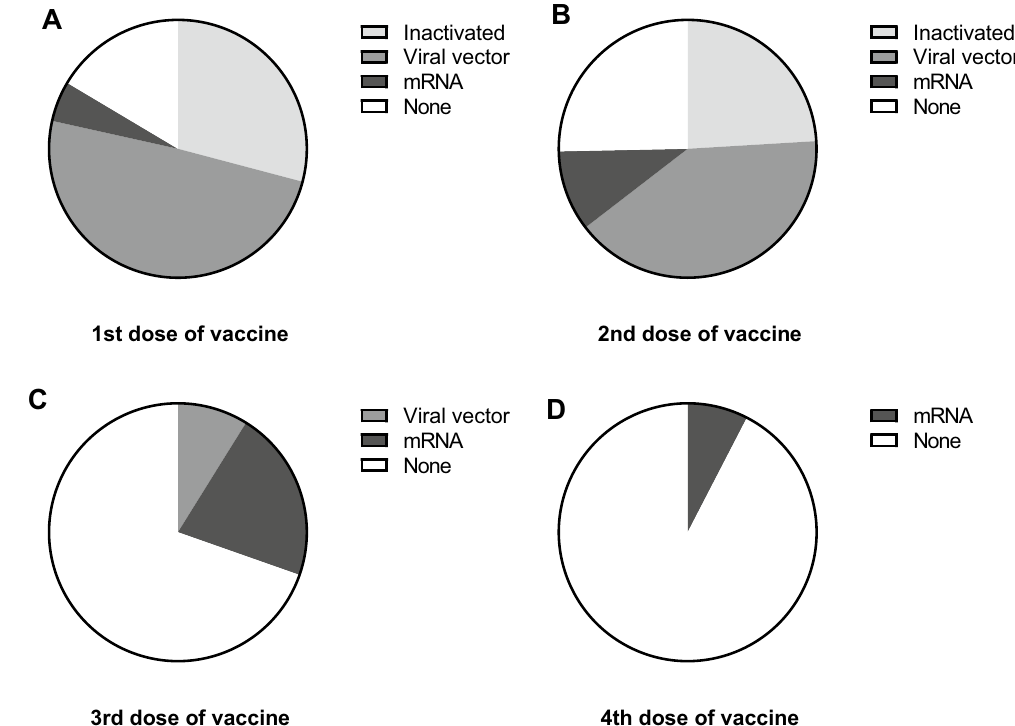
Figure 5. Types of vaccines against SARS-CoV-2 for participants are depicted in a pie chart to demonstrate the proportion of people who received the 1st dose ( A ), 2nd dose ( B ), and 3rd dose ( C ) to the 4th dose of vaccine ( D ) and inactivated vaccine, viral vector vaccine, and mRNA vaccine; None = unvaccinated